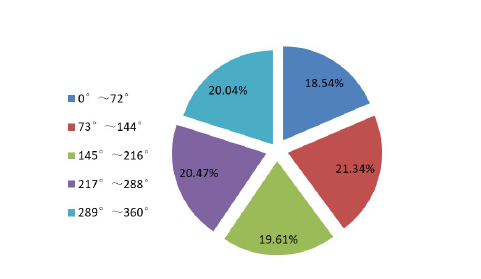
Figure 3. Percentage of aspect in Lijiang River Basin